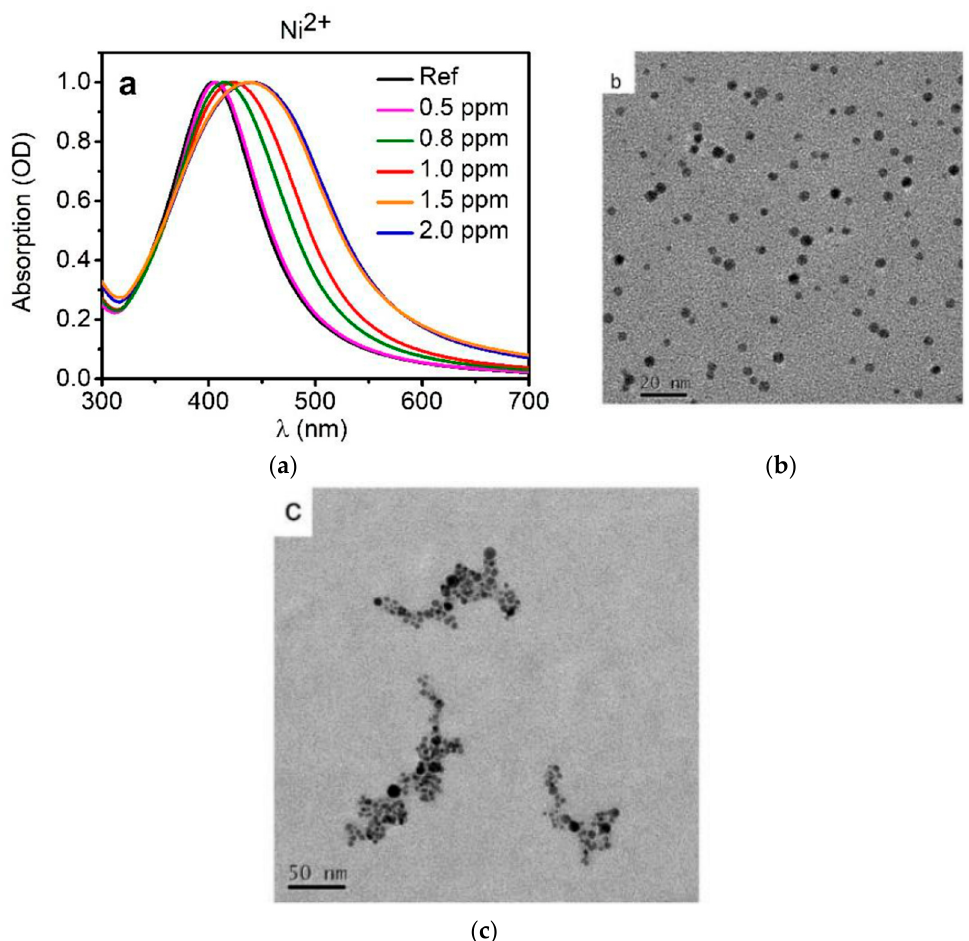
Figure 6. ( a ) Optical behaviour of AgNPs colloidal solution without (black line) and with different Ni(II) contaminations (colored lines); TEM images of ( b ) AgNPs and ( c ) the system contaminated by Ni(II) [112].